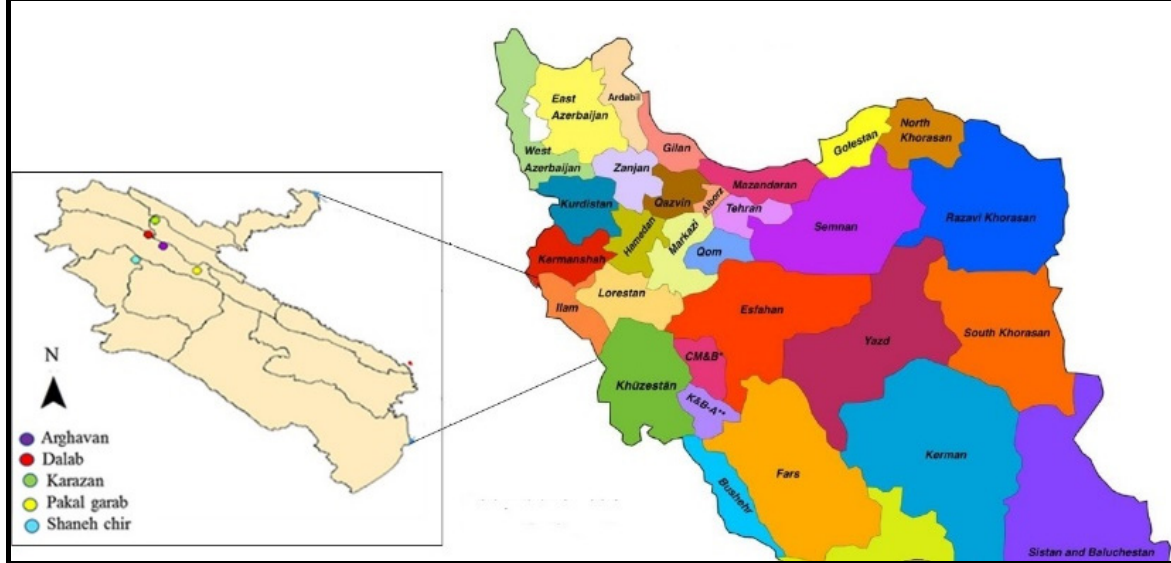
Figure 1. The position of Ilam province and sampling stands. Table 1. Fundamental characteristics of sampling sites. R.H.